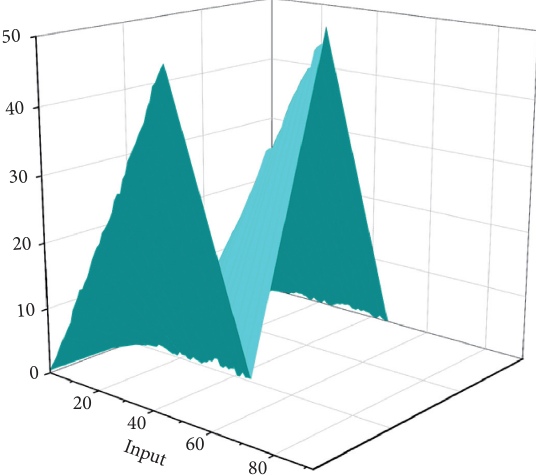
Figure 7: Relationship between reputation and investment level.